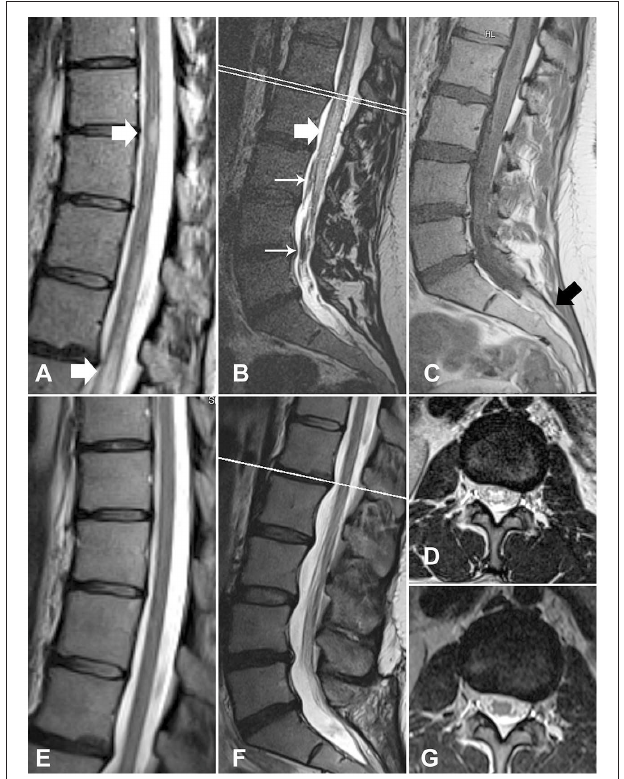
FIGURE 1 | MR images of the spinal cord of case 1, before and after treatment. (A) Myelopathic changes in the thoracic spinal cord (white arrows) ( B) Myelopathic changes in the conus medullaris (thick arrow) and thickened torturous vessels (thin arrows). (C) T1WI sequence shows a filum terminale lipoma (black arrow). ( D) A transverse section at the L1/L2 level shows myelopathic changes. ( E–G) Follow-up images demonstrate the resolution of myelopathic changes and the disappearance of the thickened